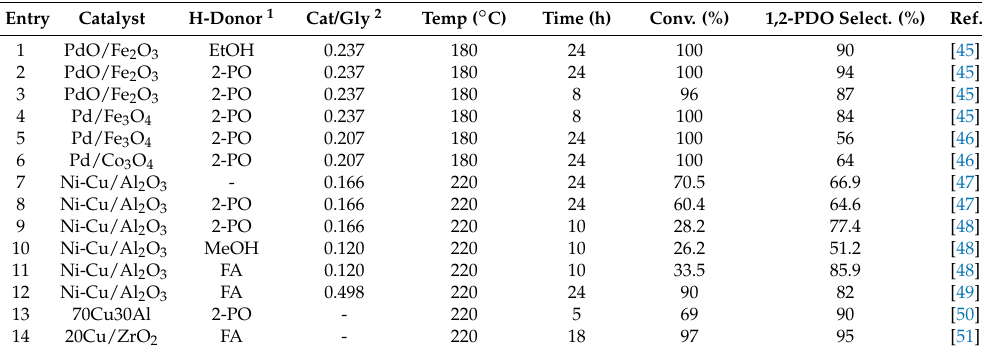
Table 1. Catalytic transfer hydrogenolysis of glycerol to 1,2-propanediol.